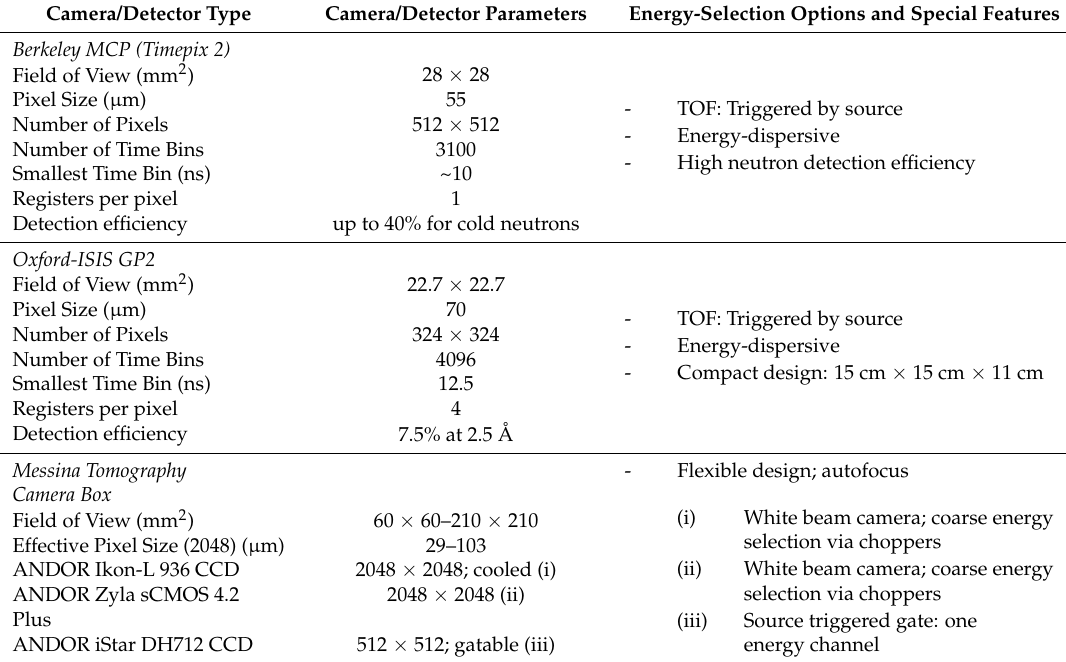
Table 1. Current IMAT camera